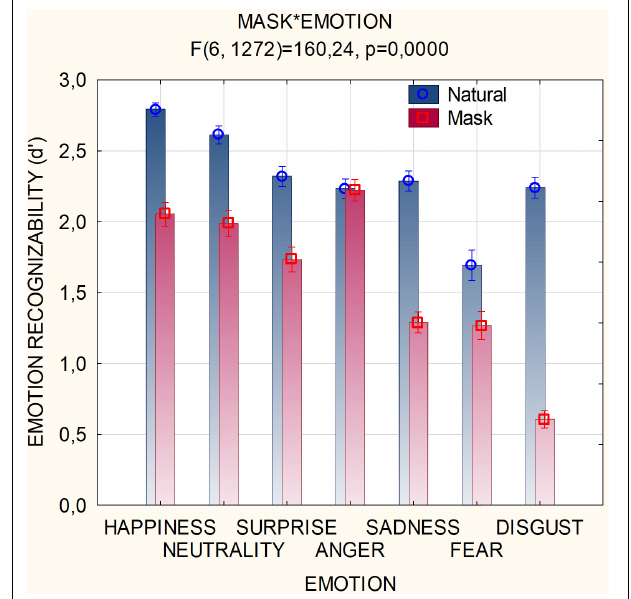
FIGURE 3 | Mean scores of recognizability (along with SE values) attributed by participants ( N = 214) to the various facial expressions as a function of masking condition. Scale ranged from 0 = “not much recognizable” to 3 = “very well